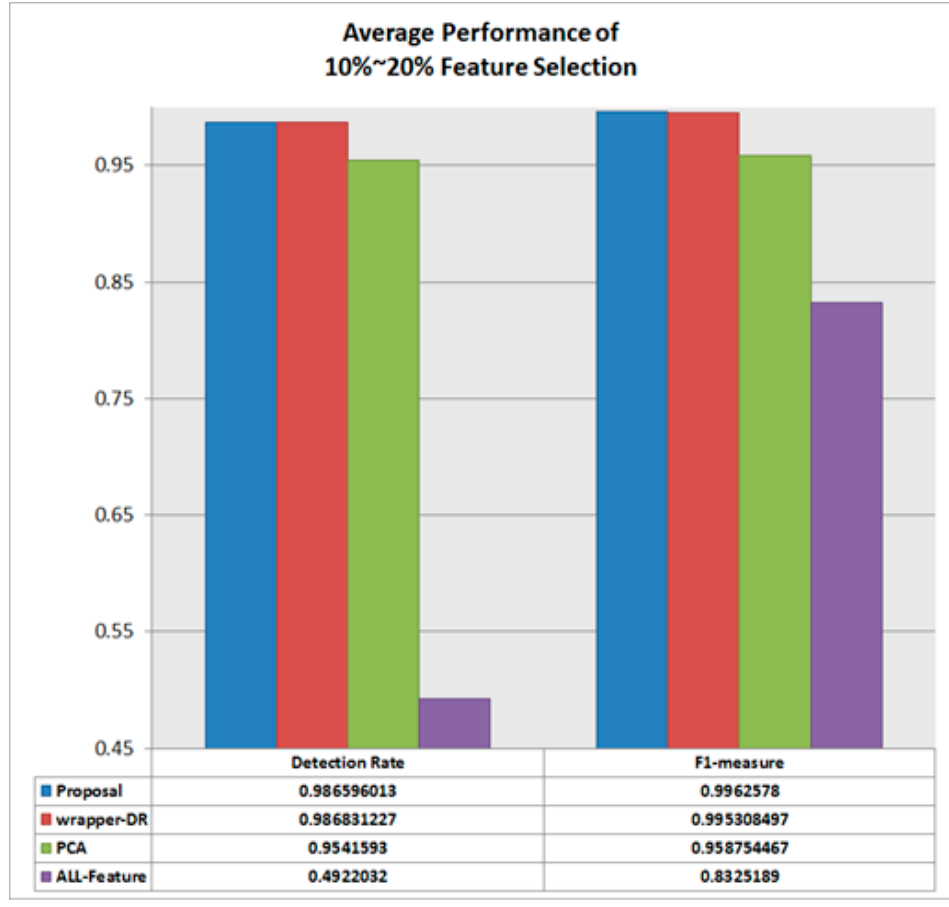
Figure 8. Feature selection vs all-feature.